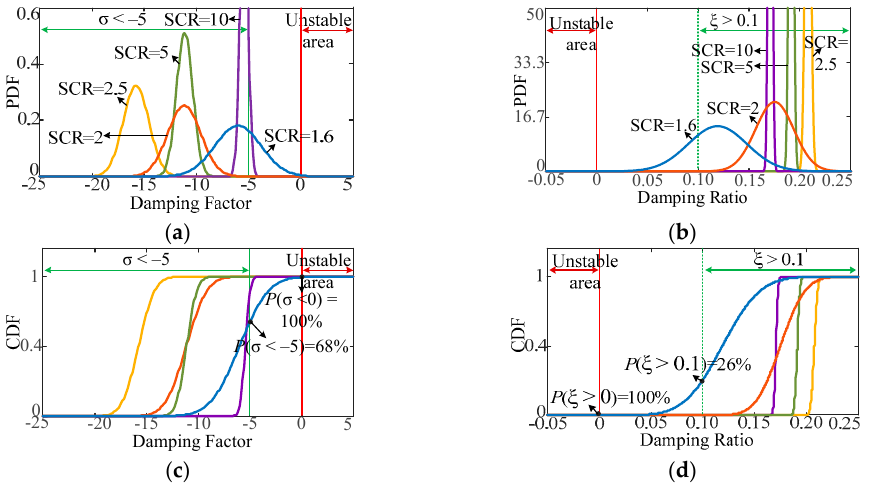
Figure 7. Probability density functions (PDFs) and cumulative density functions (CDFs) of stability indices for different grid SCRs. ( a , c ) are PDFs and CDFs of the maximum damping factor; ( b , d ) are PDFs and CDFs of the minimum damping ratio. Colors correspond to different grid SCRs in Figure 6a.